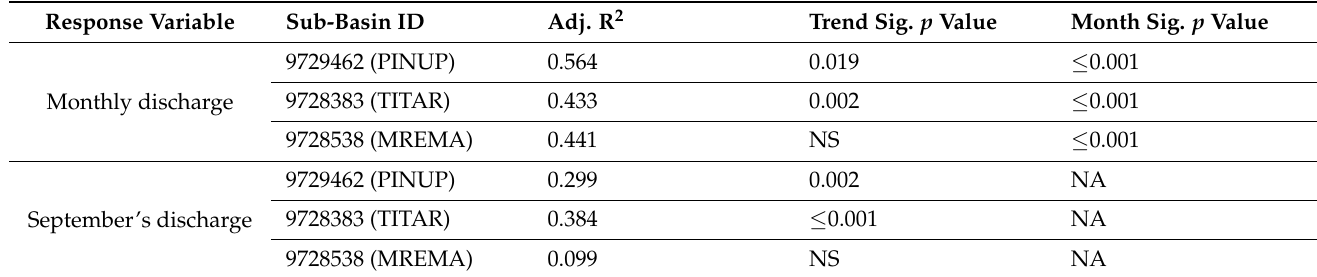
Table 4. Results of GAMs used as response variables for the monthly discharge and the discharge of